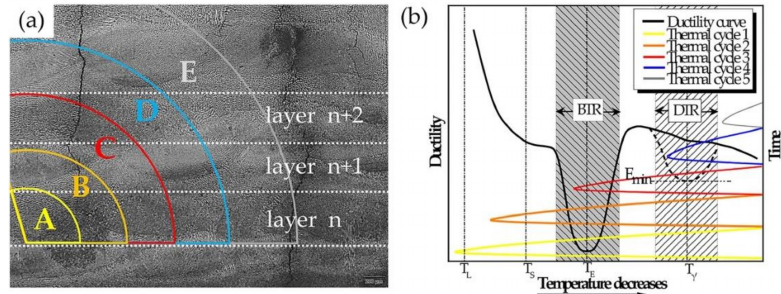
Figure 6. ( a ) Microstructure in the middle of the LFRed coating and ( b ) schematic diagram of the combined effect of ductility curve and thermal cycle. BTR—brittleness temperature region; DTR—ductility dip temperature